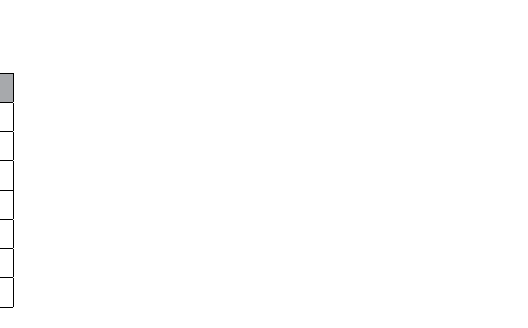
Table 2. Statistics of SSRs mined from transcription factor encoding transcripts of